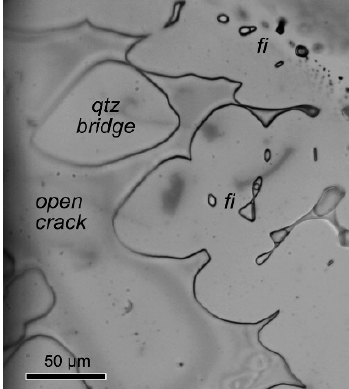
Figure 4. Photomicrograph of a partially-healed crack within quartz (top view), with the intergrowth of rounded quartz bridges and the formation of fluid-filled tubes ( fi ).